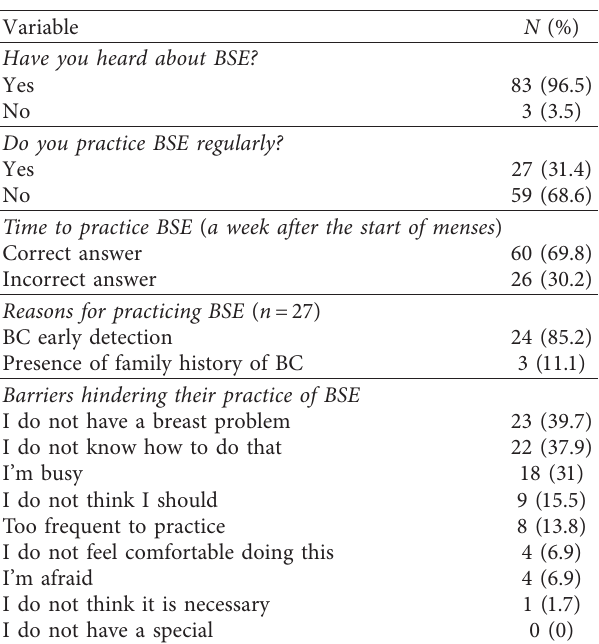
Table 4: Practicing